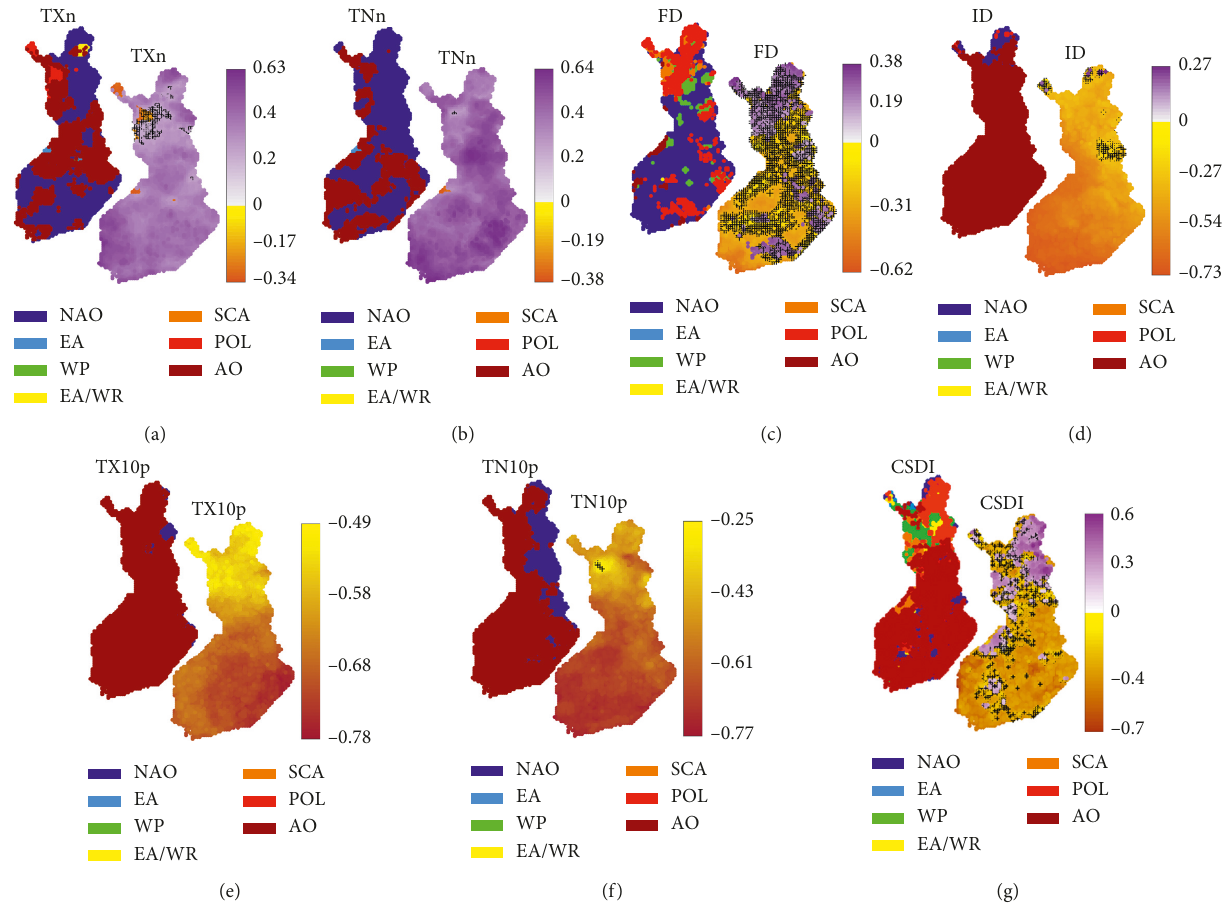
Figure 10: Spatial distribution maps of most influential NHTP (left) and its corresponding Spearman rank correlation (right) for cold temperature extreme indices including (a) TXn, (b) TNn, (c) FD, (d) ID, (e) TX10p, (f) TN10p, and (g) CSDI in Finland during 1961–2011. The stippling indicates areas where the correlations are statistically insignificant ( p >